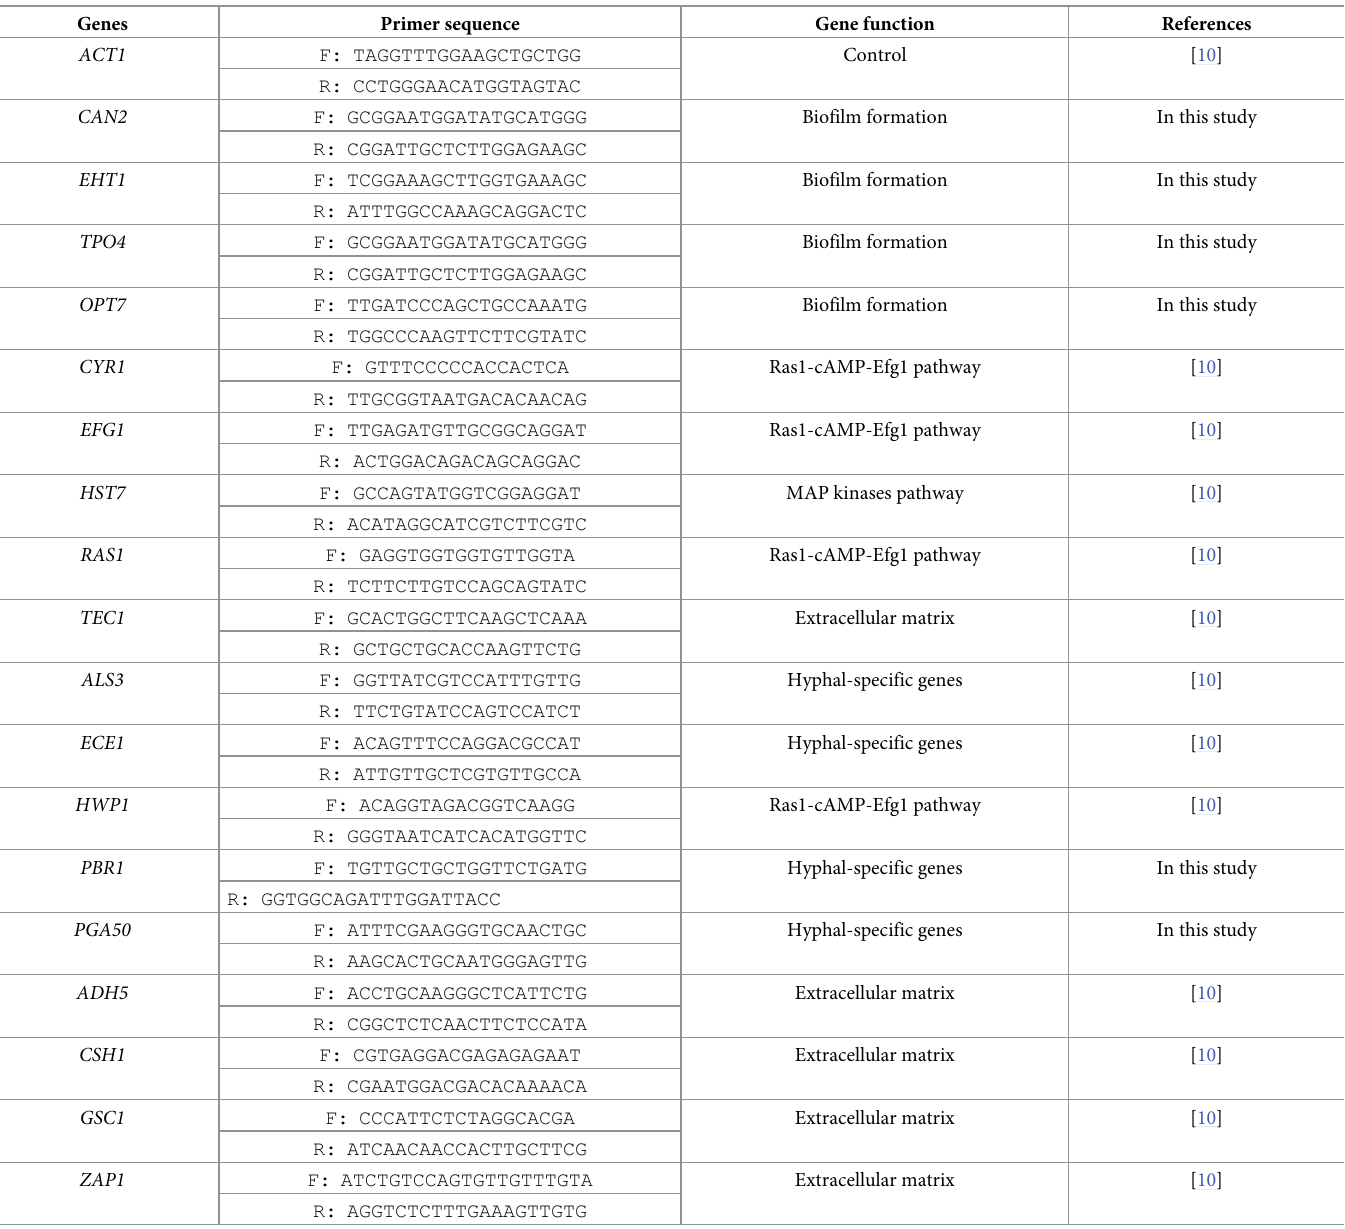
Table 2. Primers for C . albicans genes used in this study. Genes Primer sequence Gene